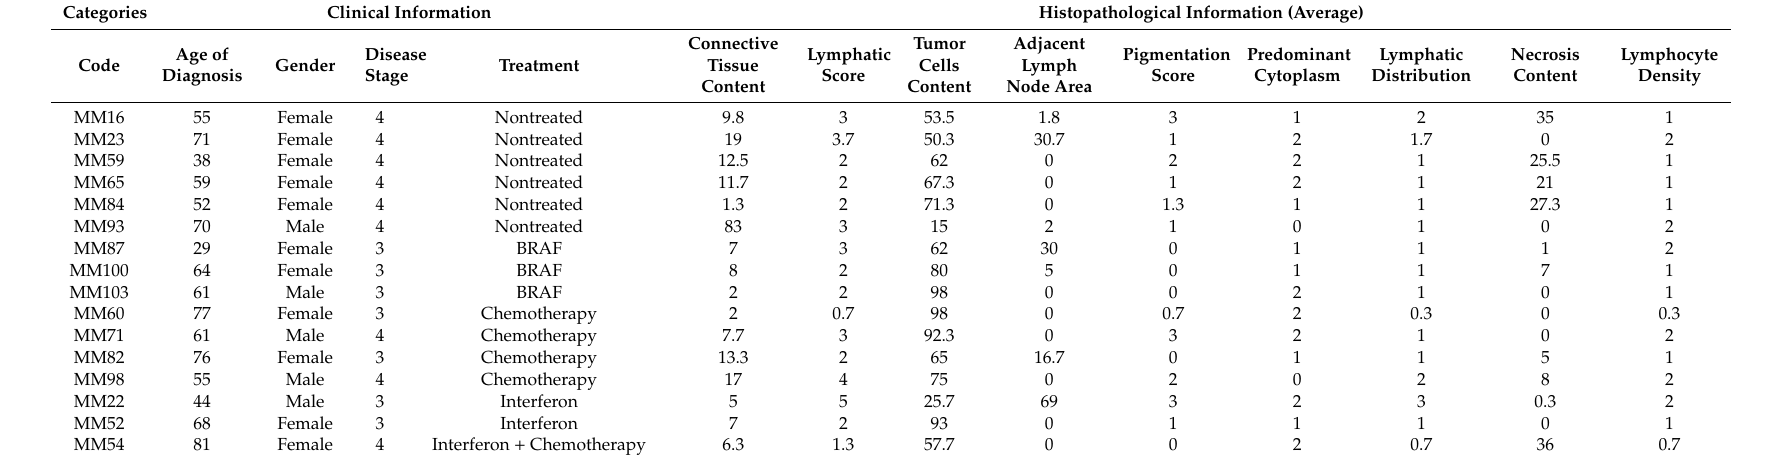
Table 1. Clinical and histopathological information of samples compared by linear